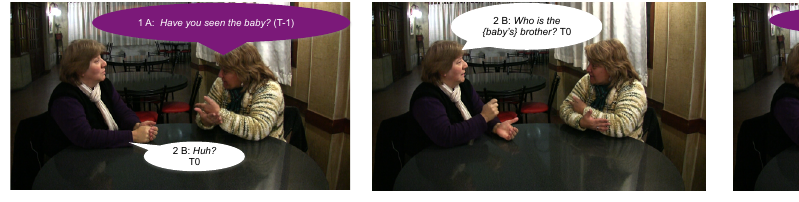
Figure 23. ‘Who?’ , thirdly Person B (left) holds the content question sign (right hand) plus index finger, ‘brother’ on the other hand